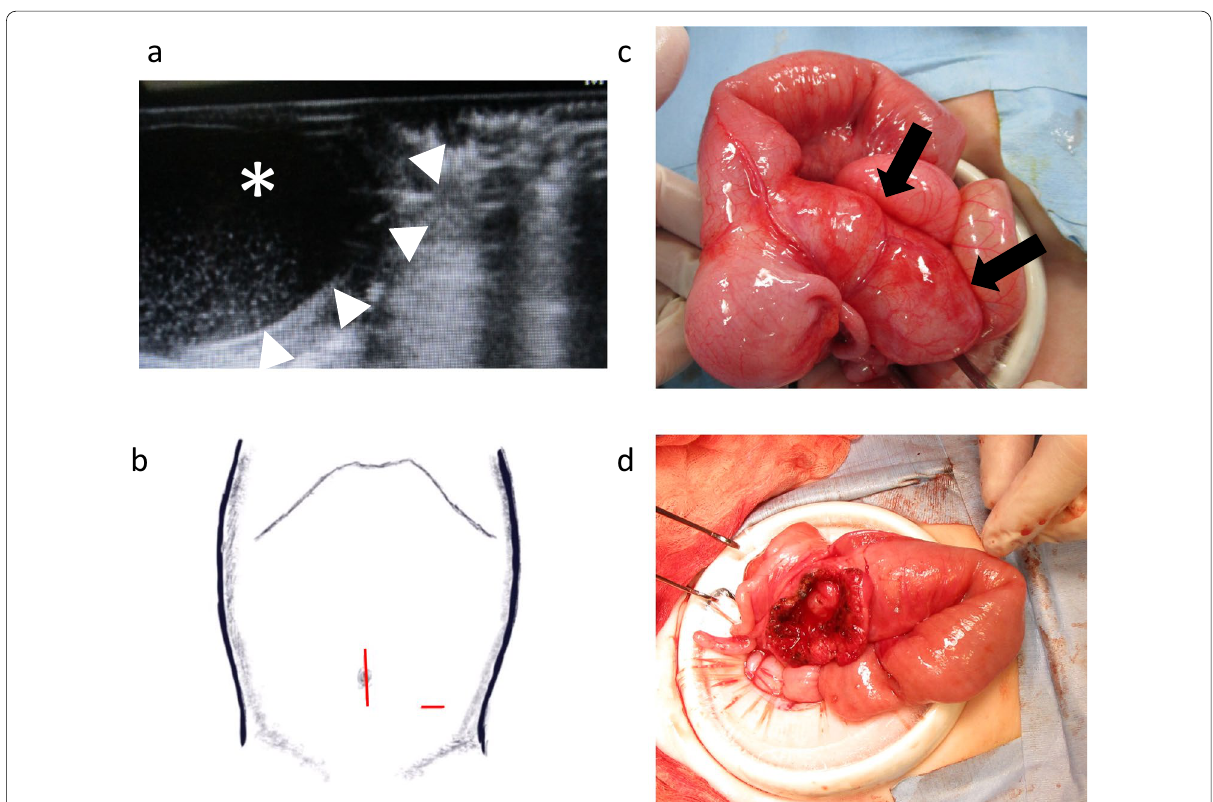
Fig. 3 Operative findings in Case 2. a Intraoperative ultrasound of the duplication cyst, containing fluid (* and arrowheads). b Laparoscopic surgery was commenced with a midline incision at the umbilicus (25 mm in length). An additional 5 mm port was inserted in the left lower abdomen. The midline incision at the umbilicus was then extended to exteriorize the cyst. c Cystic mass in the terminal ileum (40 mm, arrows) was observed. We converted to open laparotomy when we detected and diagnosed the mass as a duplication cyst. d Mucosa of the cyst was